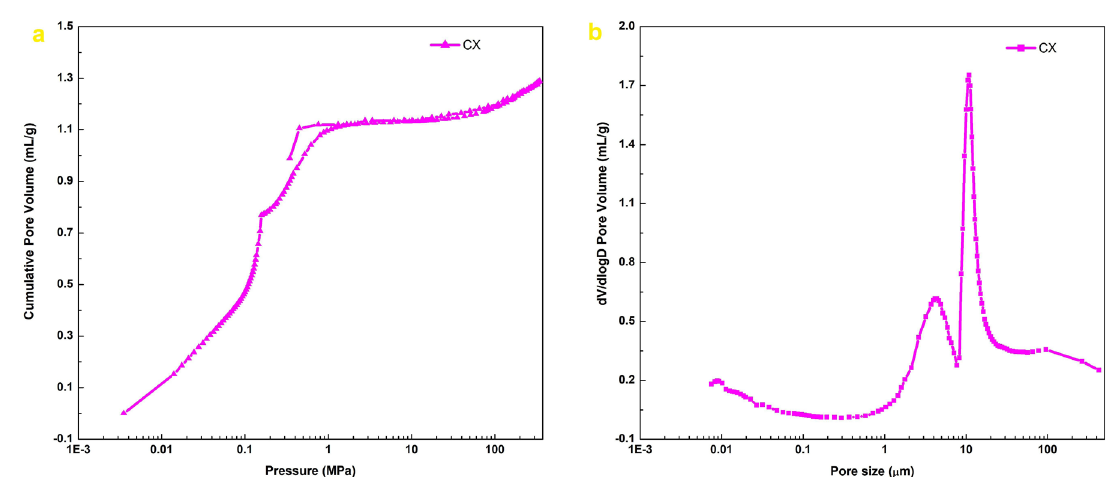
Figure 8. Mercury porosimetry of CX: a) raw intrusion-extrusion curves b) corresponding pore-size distribution.